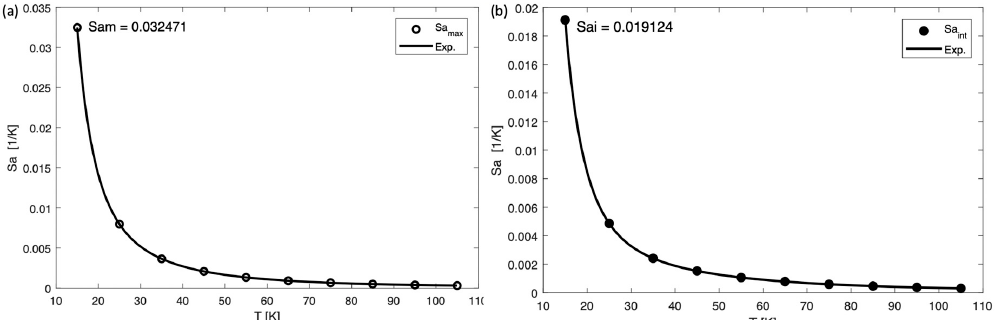
Figure 6. Plot showing the absolute sensitivity (S a ) of α -MoO 3 :Eu 3 + , Tb 3 + at di ff erent temperatures ( a ) calculated using the maximum intensity (S am ) of peaks at 512 nm of Tb 3 + and 614 nm of Eu 3 + ; ( b ) calculated using the integrated areas under the peak (S ai ) from 535 to 554 nm for Tb 3 + and from 605 to 634 nm for Eu 3 + . Table 1. Summary of the maximum relative sensitivity (S r ) for reported ratiometric thermometers based on lanthanide inorganic materials operating in the cryogenic region.